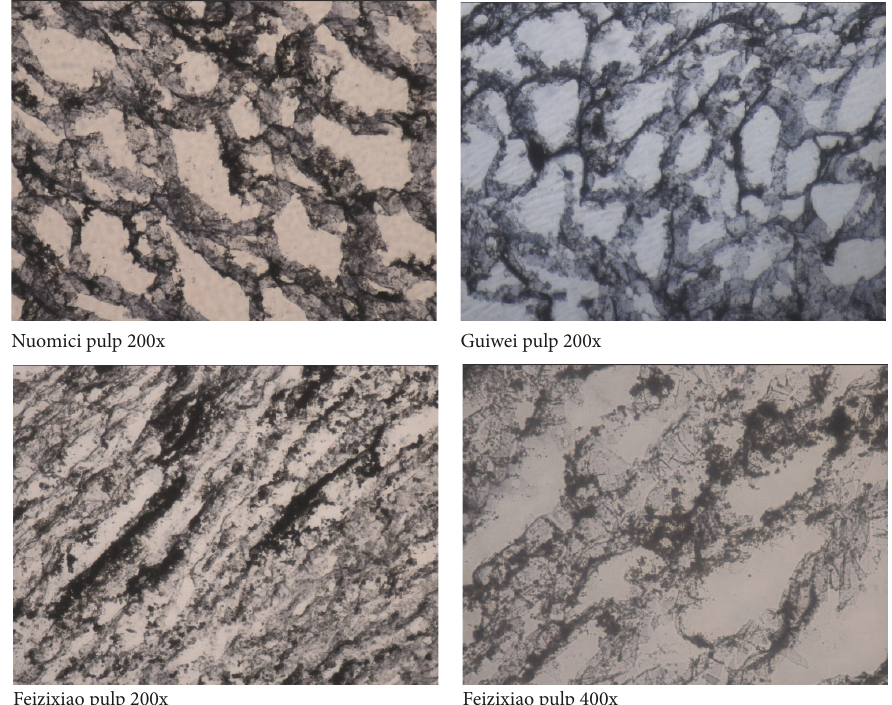
Figure 4: The light micrographs for lychee pulp of three